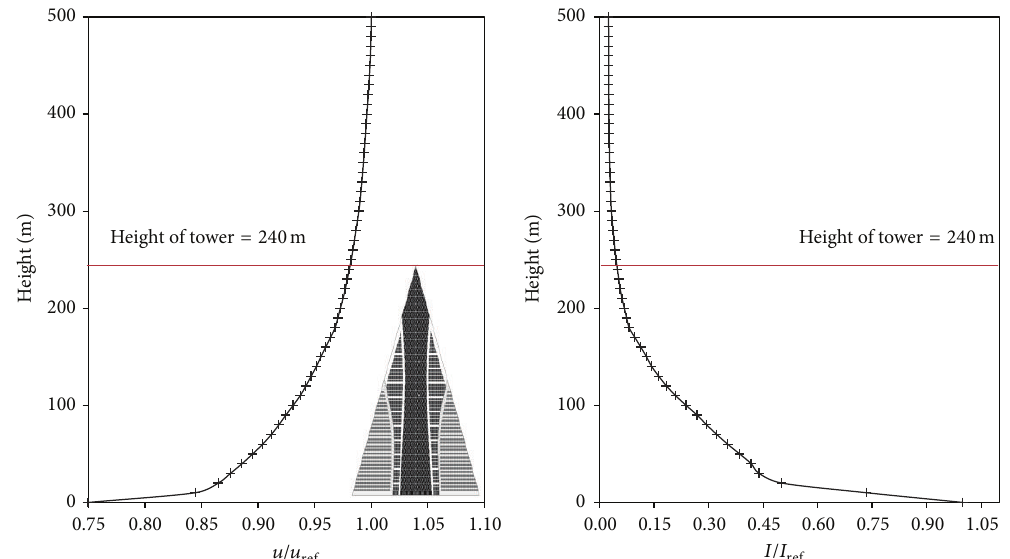
Figure 8: Representation of the boundary layer profile and turbulence intensity.